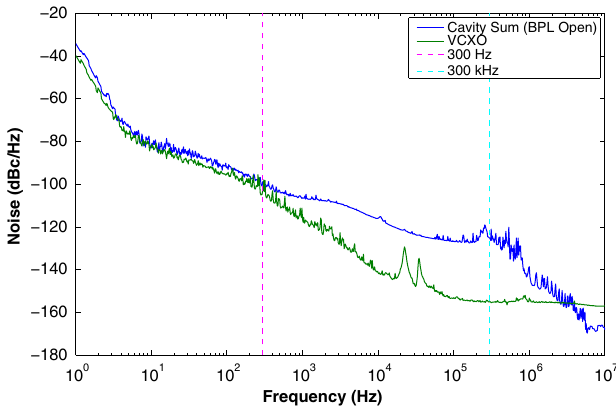
FIG. 3. Phase noise power spectra for beam 2 cavity sum and VCXO (BPL open).